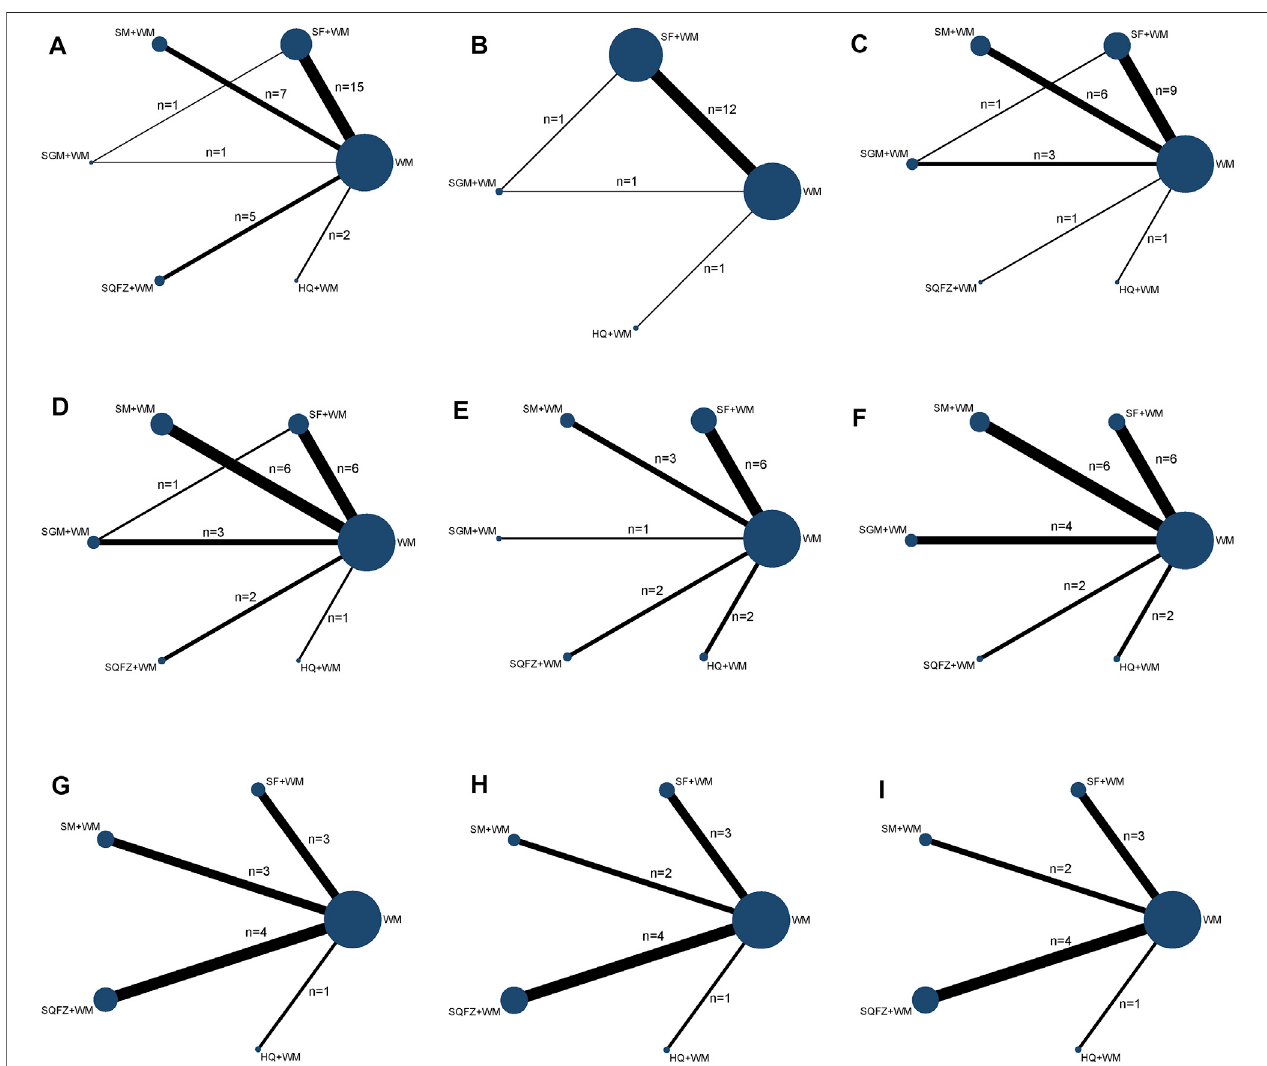
FIGURE2 | Network graph ofthe different outcomes. Note: (A) : APACHE IIscore; (B) : 28-days mortality; (C) : PCT; (D) : CRP; (E) : IL-6; (F) : TNF- α ; (G) : CD4 + ; (H) : CD8 + ; (I) : CD4 + /CD8 + .